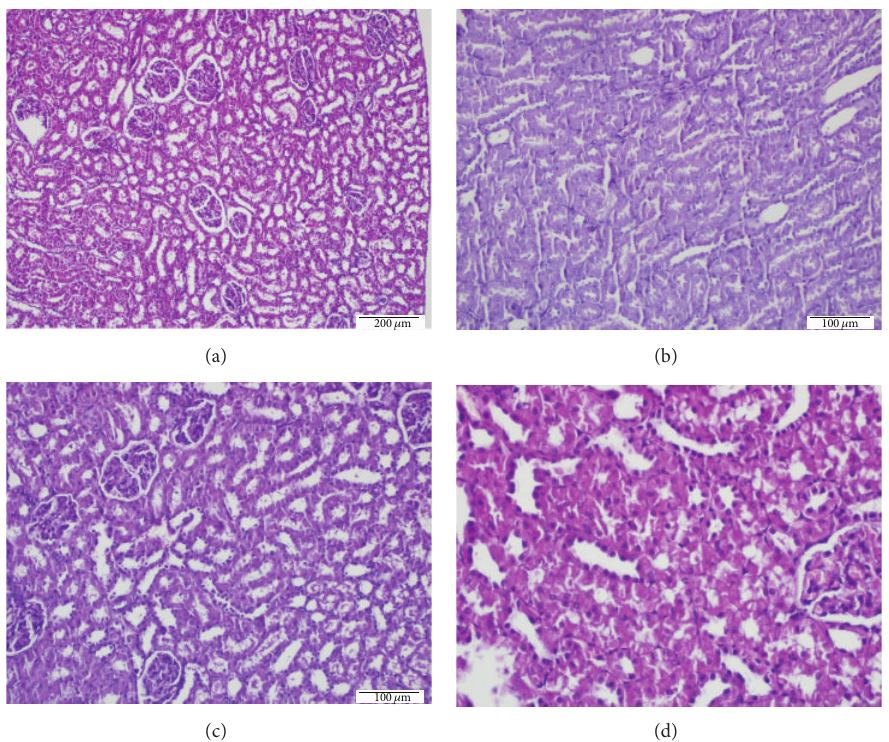
Figure 2: Evaluation of mitosis (hematoxylin and eosin method). (a) Control rats with normal renal histology (H&E, × 100). (b) Common mitotic increase in the rats with Dichlorvos (H&E, × 100) (D). (c) Decreasing mitotic density and regenerative changes in the rats given CAPE following Dichlorvos (H&E, × 200) (D + CAPE). (d) Relative decrease in the mitotic density and regenerative changes in the rats given CAPE and IL following Dichlorvos (H&E, × 200) (D + CAPE +